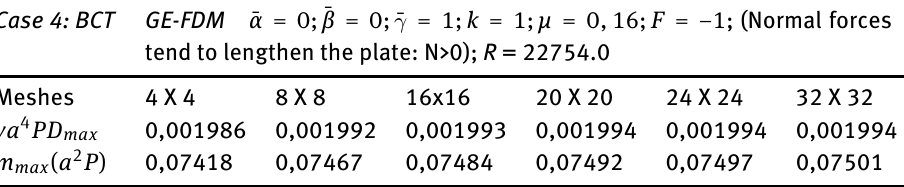
Table 6: Deflection (cm) and moment of the plate with variable thicknesses under a uniformly distributed load (BCVT). Case 1: BCVT